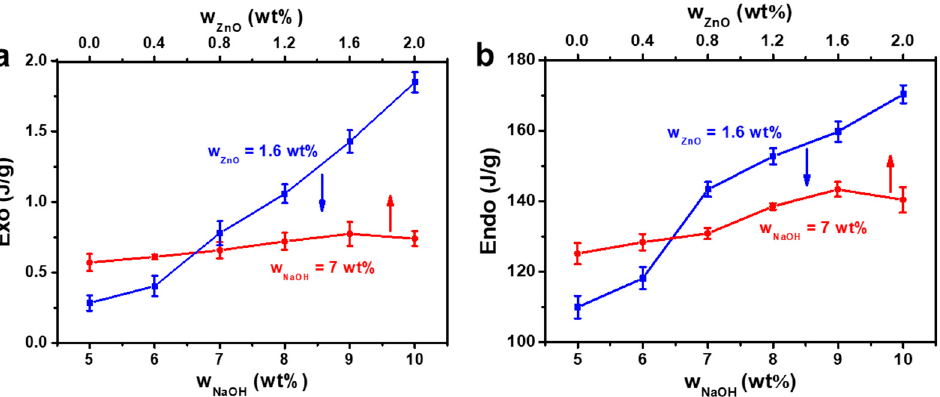
Figure 3. ( a ) The dissolution enthalpies of CC and ( b ) The melting enthalpies of CC/NaOH/Na 2 Zn(OH) 4 /H 2 O frozen mass as a function of NaOH and ZnO contents. mass as a function of NaOH and ZnO